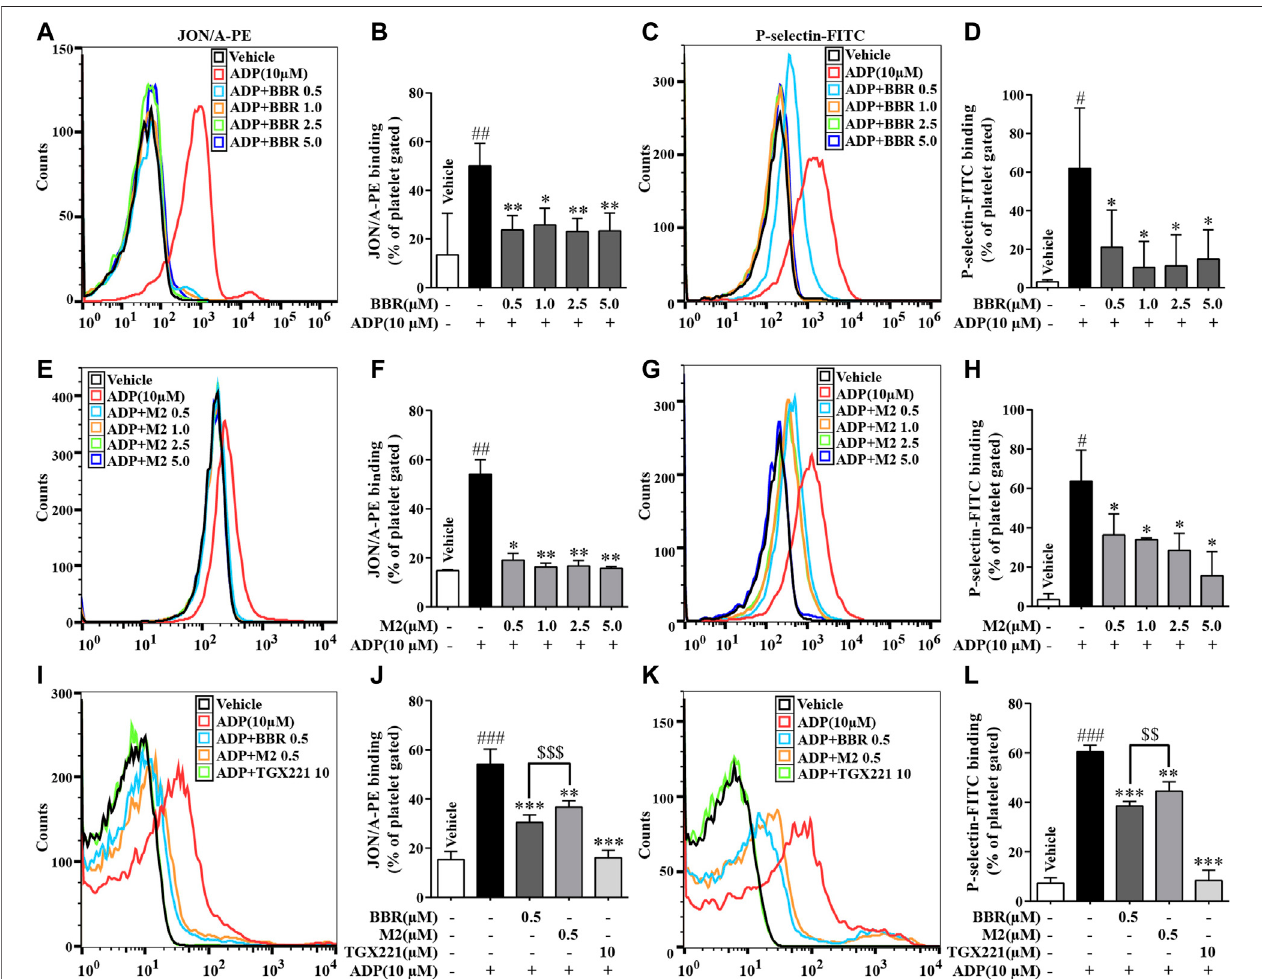
FIGURE 2 | Effects of BBR and M2 on platelet activation induced by ADP in vitro . The WPs were pretreated with different compounds or the vehicle control (0.1% DMSO)for10 minand stimulated with10 μ MofADPfor10 min.Aftertreatment,thePE-conjugated JON/AantibodyandtheFITC-conjugatedP-selectin antibodywere used to detect the integrin α IIb β 3 active form and P-selectin expression on the platelet surface by fl ow cytometry. The positive platelet ratios in gated platelets were calculated and plotted as indicated. (A-D) The WPs were pretreated with BBR at indicated concentrations. (E-H) The WPs were pretreated with M2 at indicated concentrations. (I-L) TheWPswerepretreatedwithBBR,M2,orTGX221atindicatedconcentrations.Thehistograms (A,C,E,G,I,K) arerepresentativesoffouror fi ve independent fl ow cytometry experiments, and the quantitative results (B, D, F, H, J, L) are expressed as their mean ± SD. Statistically signi fi cant differences compared withthevehiclecontrolgroupareindicatedby # p < 0.05, ## p < 0.01,and ### p < 0.001.Statisticallysigni fi